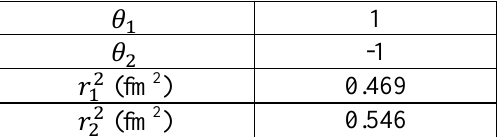
Table 1: Parameter of the neutron charge